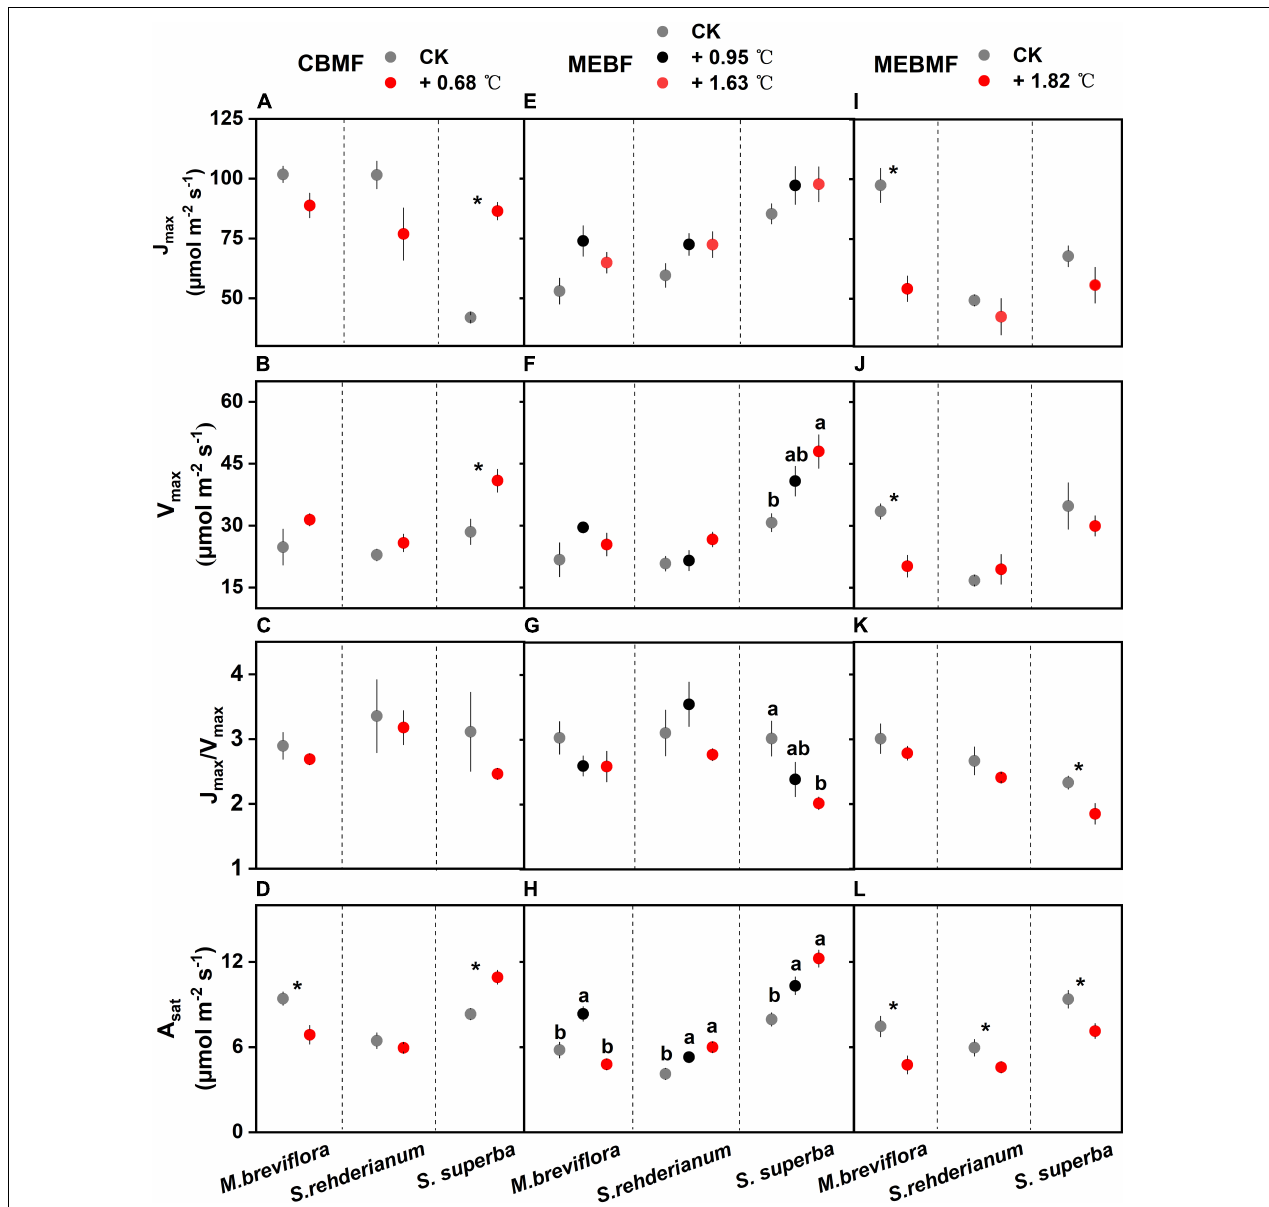
FIGURE 5 | (A,E,I) The area-based maximum rate of photosynthetic electron transport (J max , µ mol m − 2 s − 1 , n = 6), (B,F,J) the area-based maximum rate of photosynthetic Rubisco carboxylation (V n = 12) of Machilus breviflora , Syzygium rehderianum and Schima superba exposed to various warming treatments in coniferous and broadleaf mixed forest (CBMF), mountain evergreen broadleaf forest (MEBF) and monsoon evergreen broadleaf forest (MEBMF). Different lowercase letters above the error bars (standard errors) indicate significant differences in J max , V max , J max /V max and A sat from August 2018 or 2019 to August